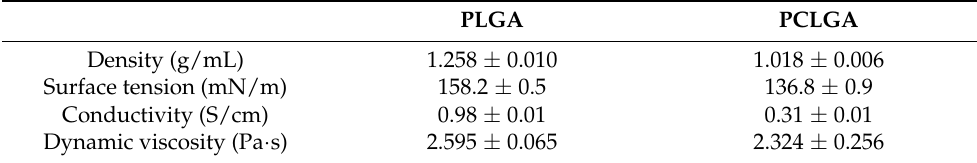
Table 3. Physico-chemical properties of the polymeric solutions presented in Table